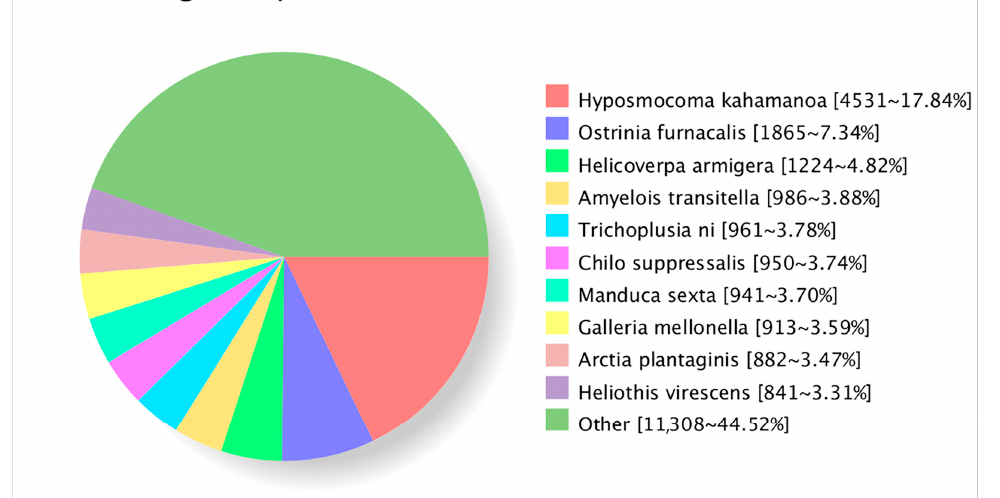
Figure 2. Homologous species distribution of T. absoluta annotated in NR.